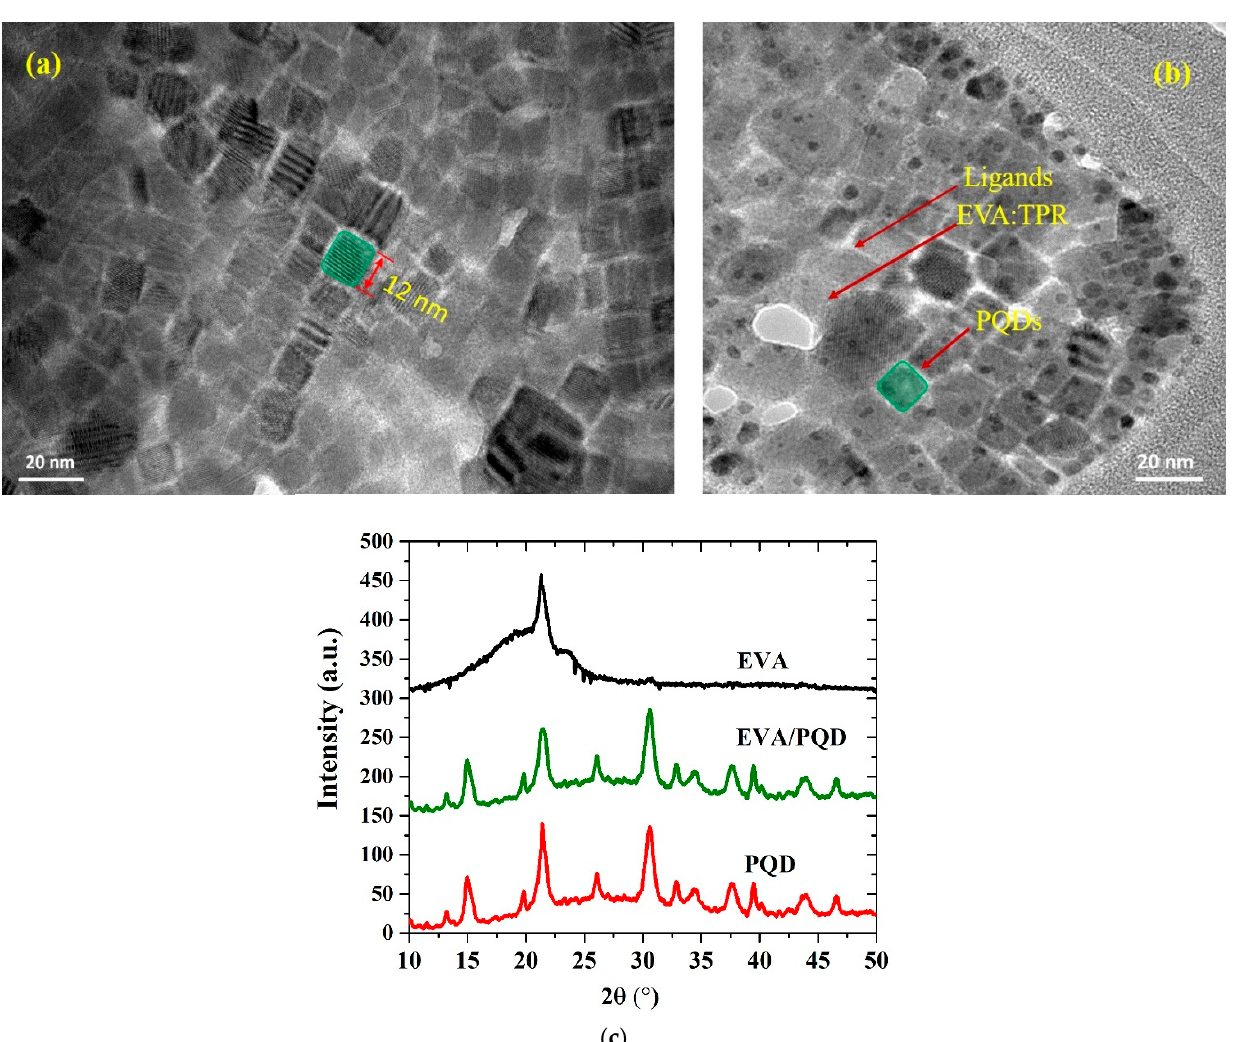
Figure 2. TEM images of ( a ) pure perovskite quantum dots (PQDs) and ( b ) PQDs: ethylene vinyl acetate/terpene phenol (EVA-TPR) at a scale of 20 nm. ( c ) XRD patterns of the pure EVA, the pure PQDs, and the PQD: EVA-TPR films.